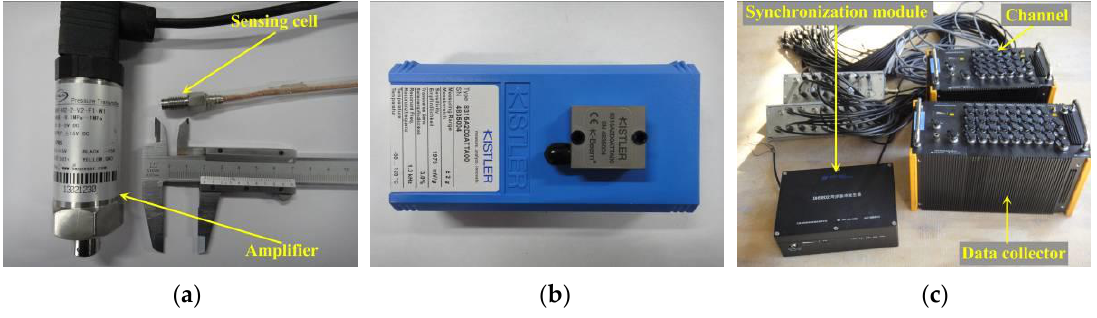
Figure 7. Measurement sensor or equipment: ( a ) pressure sensor; ( b ) accelerometer; and ( c ) the DH5902 data collectors.